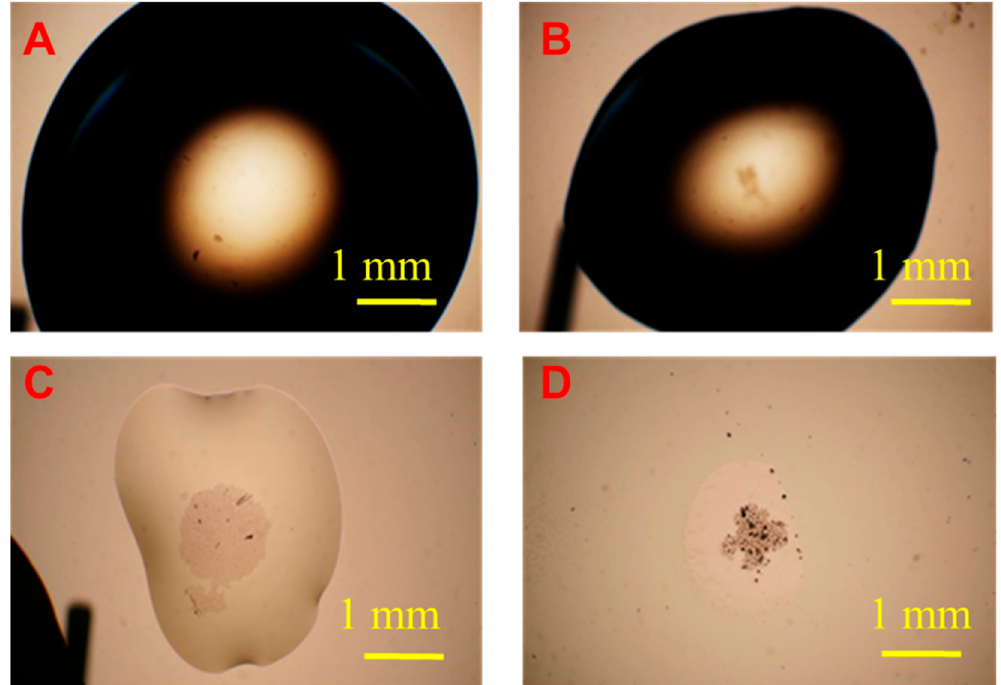
Figure 2. Snapshots of micro-photographic image showing the shape evolution of 100 μ L sample droplet containing 1000 CFU/mL Salmonella during drying processes taken in ( A ) 0 min. (original hemispherical droplet, dia. ~9 mm); ( B ) 13 min. (evaporating hemispherical droplet, dia ~4.5 mm); ( C ) 23 min. (flatten droplet as a film, dia ~2 mm); ( D ) 30 min. (dried spot). Colony forming units, CFU.